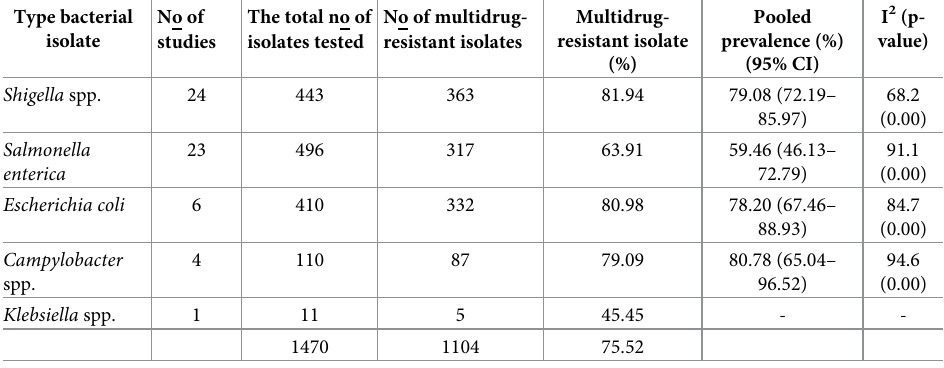
No of multidrug- resistant isolates